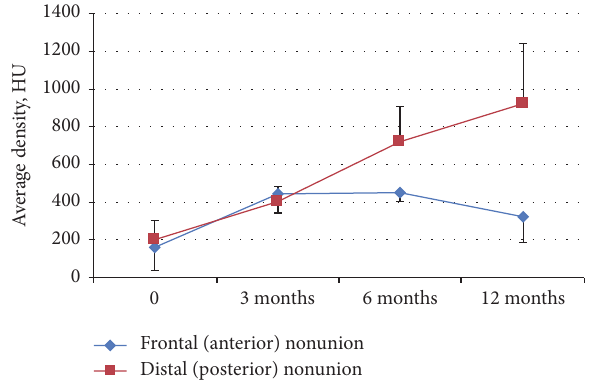
Figure 4: Average density in the regions of nonunions (0) and the sites of gene-activated bone substitute implantation in 3, 6, and 12 months after